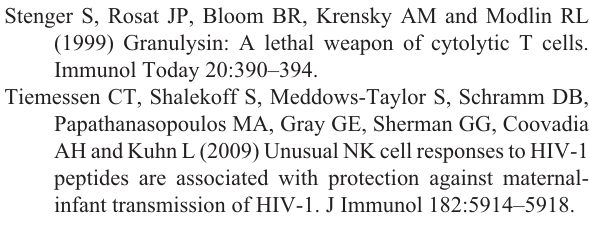
Table S1 - The results from power analysis (Fisher’s exact